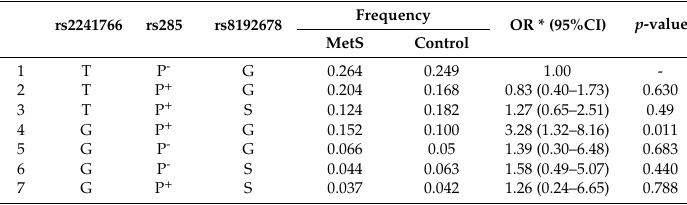
Figure 1. Paired single nucleotide polymorphism (SNP) linkage disequilibrium analysis. Table 5. Association of Haplotype with MetS risk.